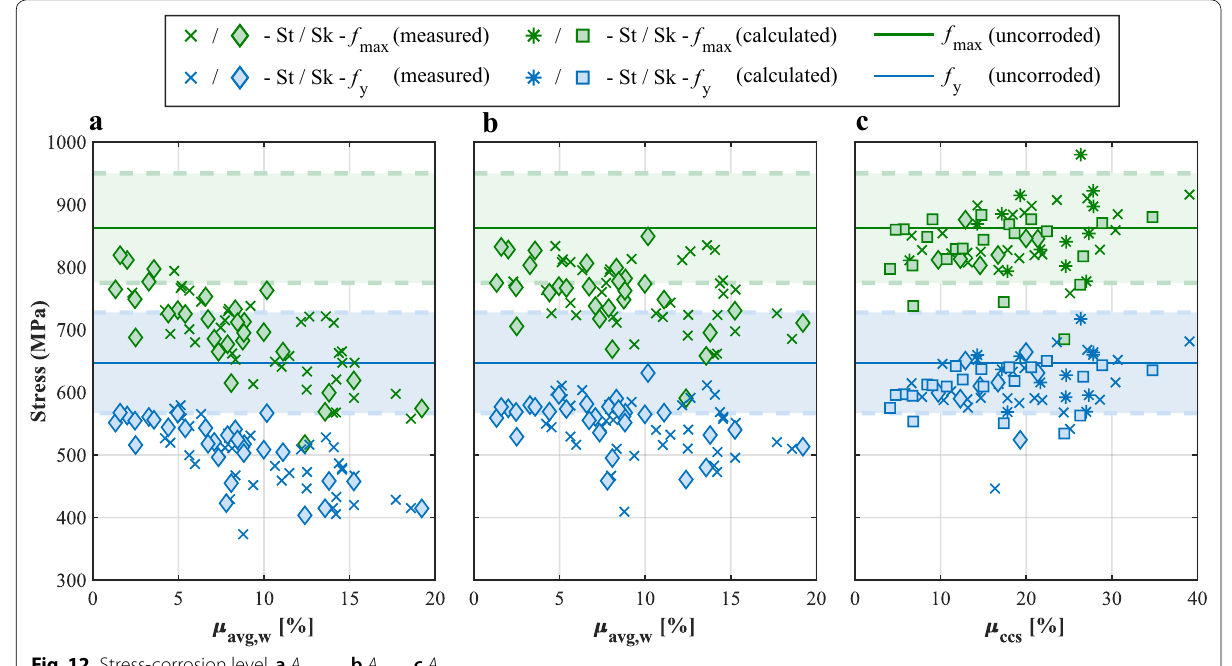
Fig. 12 Stress-corrosion level. a A avg,unc , b A avg,w c A ccs